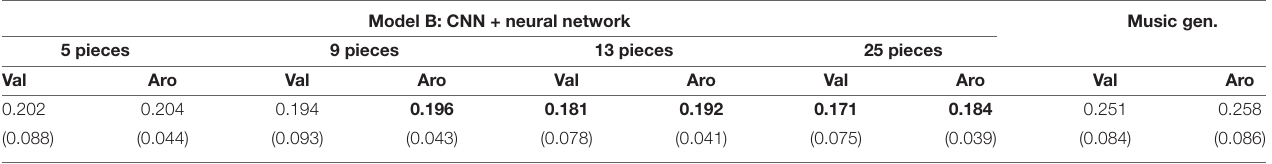
TABLE 3 | Participants’ mean and standard deviation of RMSEs of felt and predicted emotions using EEG data and music generator’s inputs: Music gen. indicates emotion prediction using music generator’s inputs. Model B: CNN + neural network Music gen.